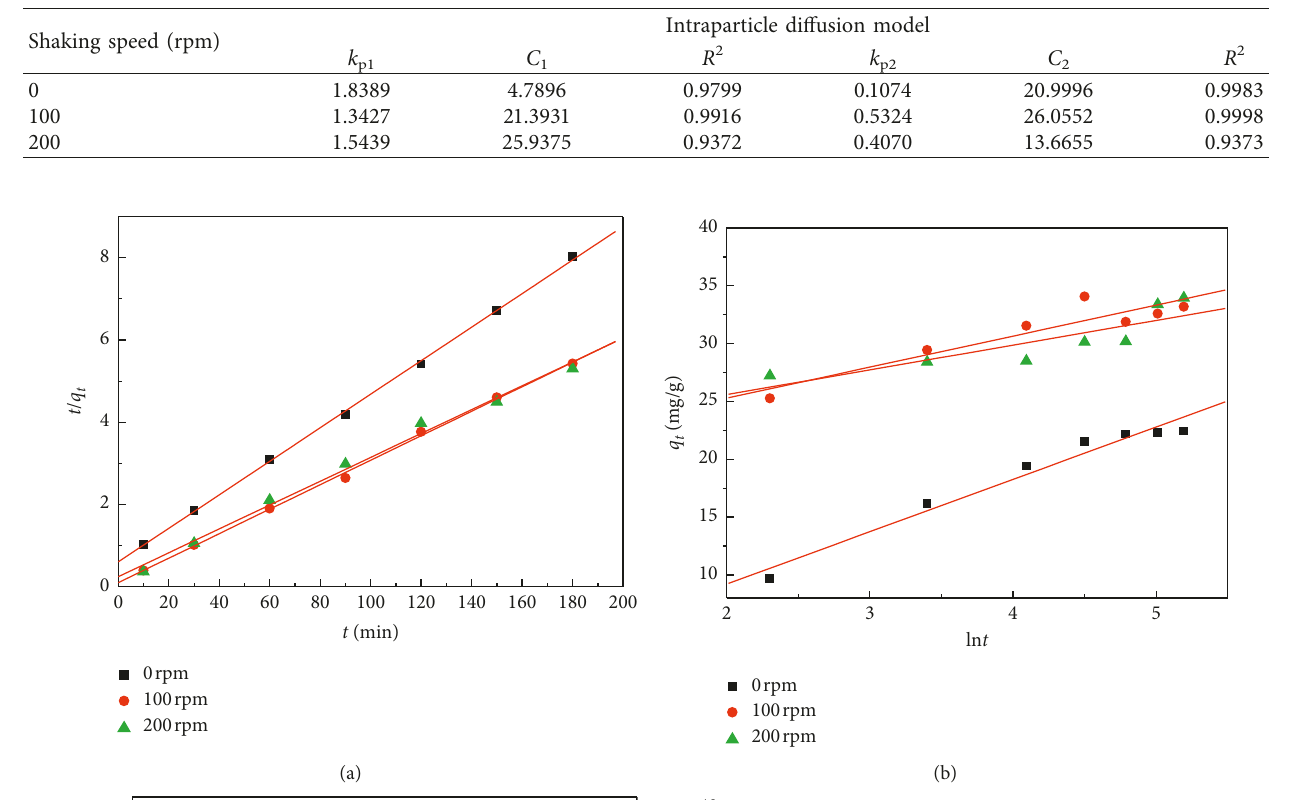
Table 7: Kinetic parameters of adsorption using the intraparticle diffusion model.